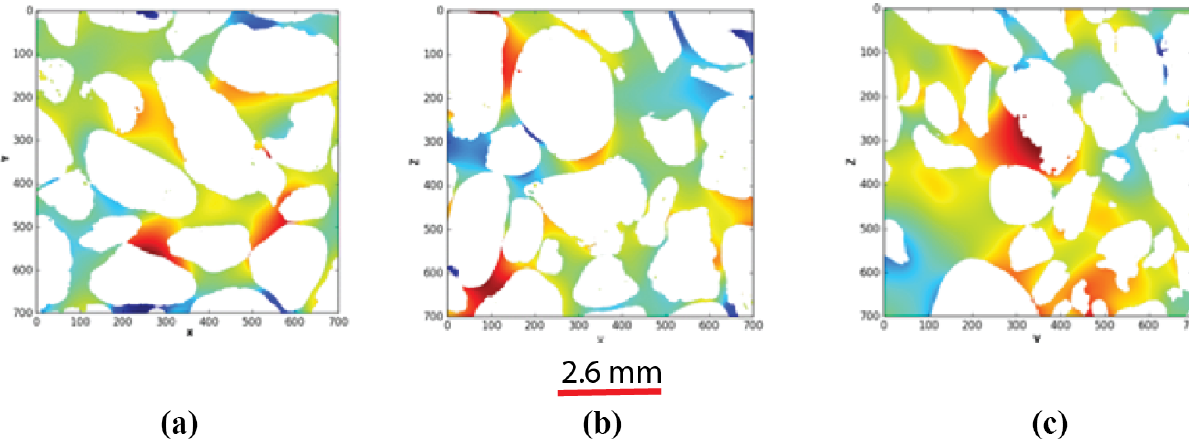
Figure 9. Electrical potential field images (a) along the x direction, (b) along the y direction, and (c) along the z axes.